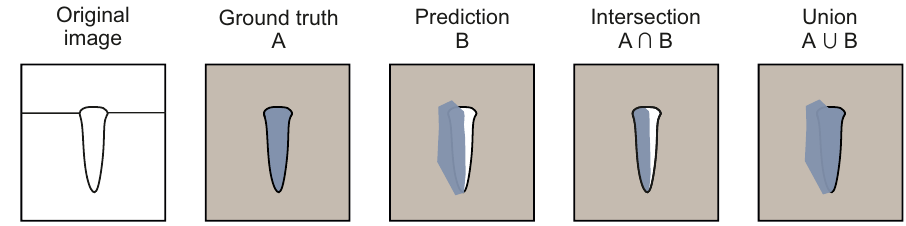
Figure 4. Ground truth and prediction